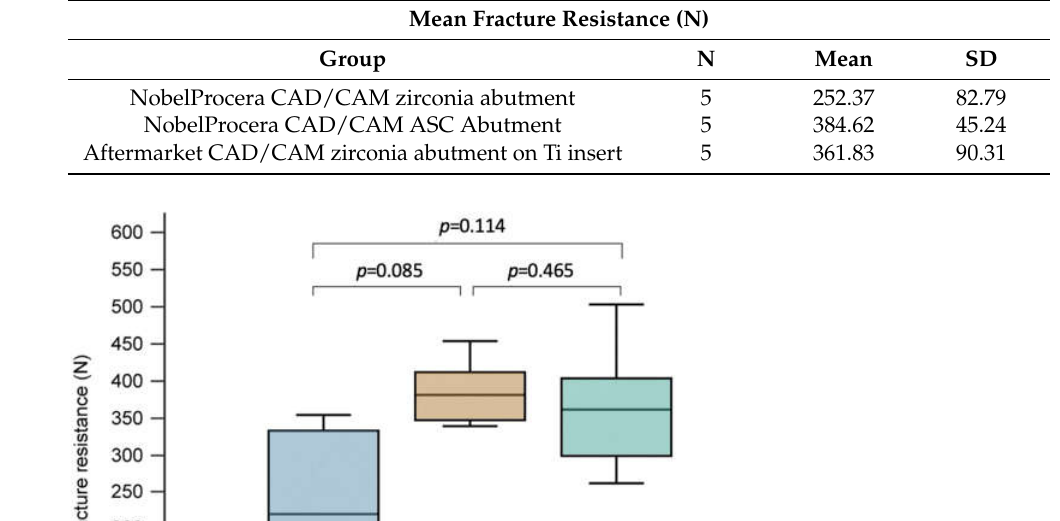
Figure 4. Loading of the assembled specimen with a universal testing machine at 30°.